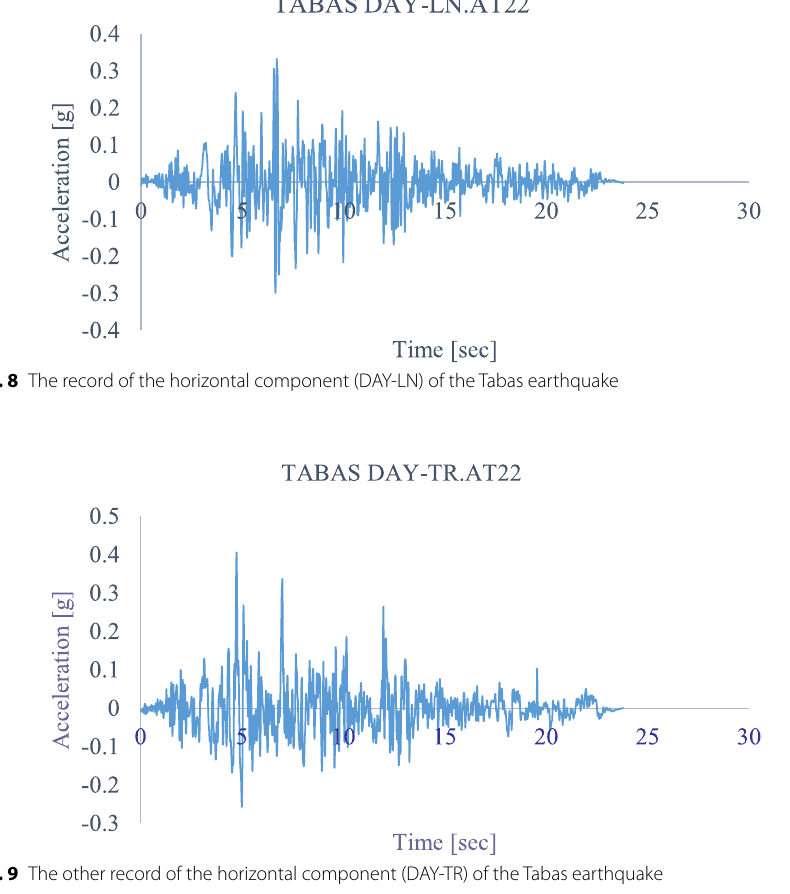
The magnitude of the Loma Prieta earthquake is equal to 6.7 Richter, but the duration and intensity of the Landers and Loma Prieta earthquakes are much greater than the Tabas earthquake. Because of this reason, to investigate the effect of the magnitude of